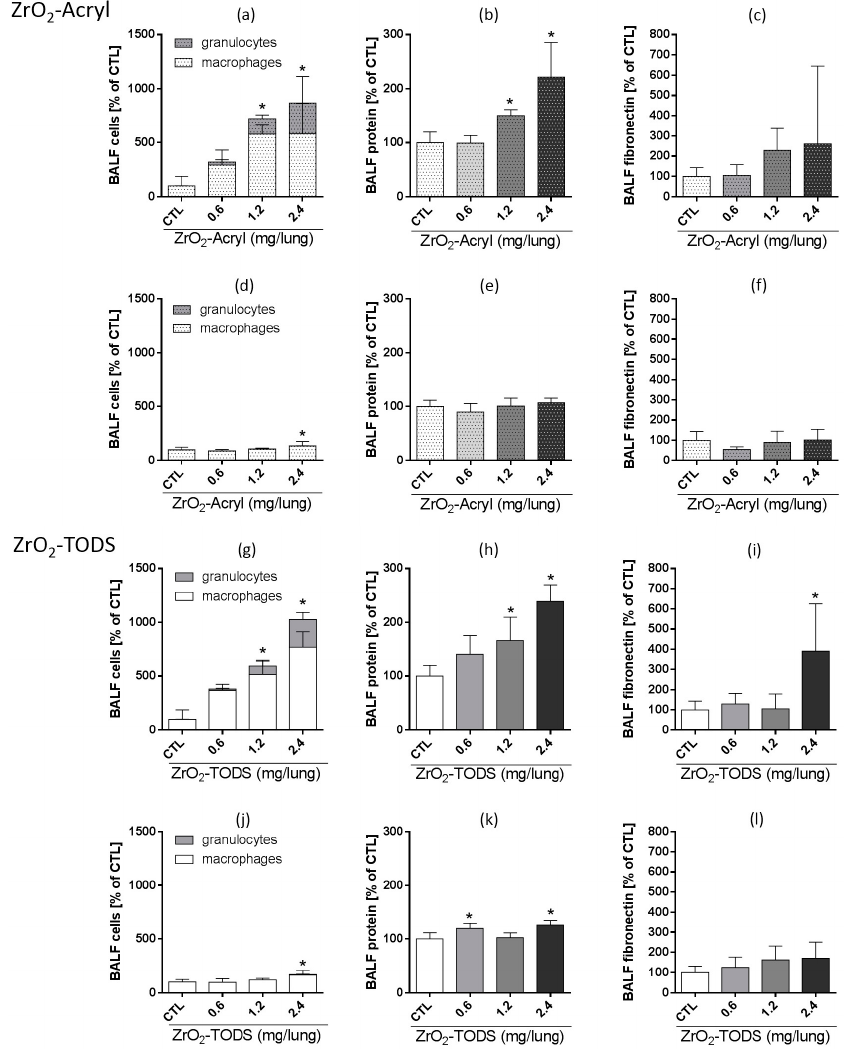
Figure 7. Effects of ZrO 2 -Acryl and ZrO 2 -TODS on the rat lung. Indicated doses of ZrO 2 -Acryl were intratracheally delivered and effects on BALF parameters are shown as percent vehicle control at three ( a – c , g – i ), and 21 days ( d – f , j – l ) post-administration. ( a , d and g , j ) Differential cell counts reveal alveolar macrophages and neutrophilic granulocytes as the dominant cell types. ( b , e and h , k ) Protein concentration as measured with the Lowry method. ( c , f and i , l ) Fibronectin was quantified by a specific enzyme-linke immunosorbent assay (ELISA). Values are mean ± SD from n = 5 rats; * p < 0.05 was revealed by one-way analysis of variance (ANOVA) followed by Dunnett’s multiple comparison